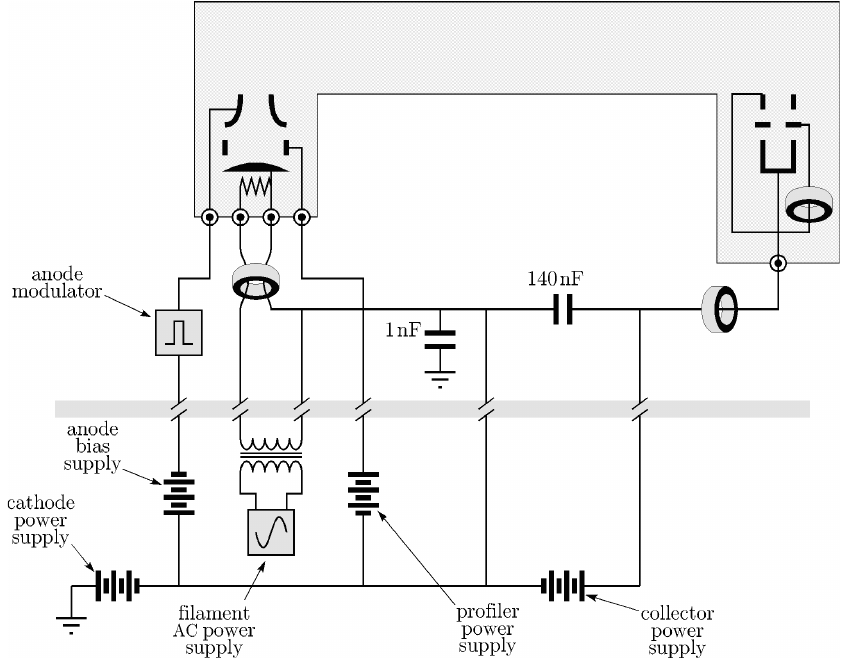
FIG. 16. Schematic of the TEL electrical circuitry. The shaded barrier represents about 60 meters between the Tevatron tunnel and the gallery where supplies and electronics are stationed. The filament is at cathode potential, so the AC power supply providing the cathode heating needs to be isolated from ground via a transformer, and its signal needs to be subtracted from the cathode current meter.